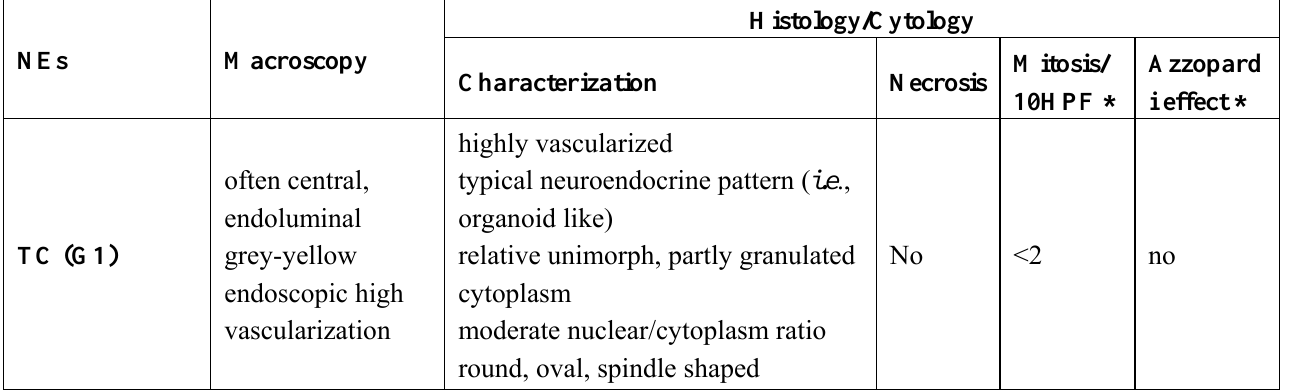
Table 1. Macroscopical, histological and cytological features of pulmonary neuroendocrine